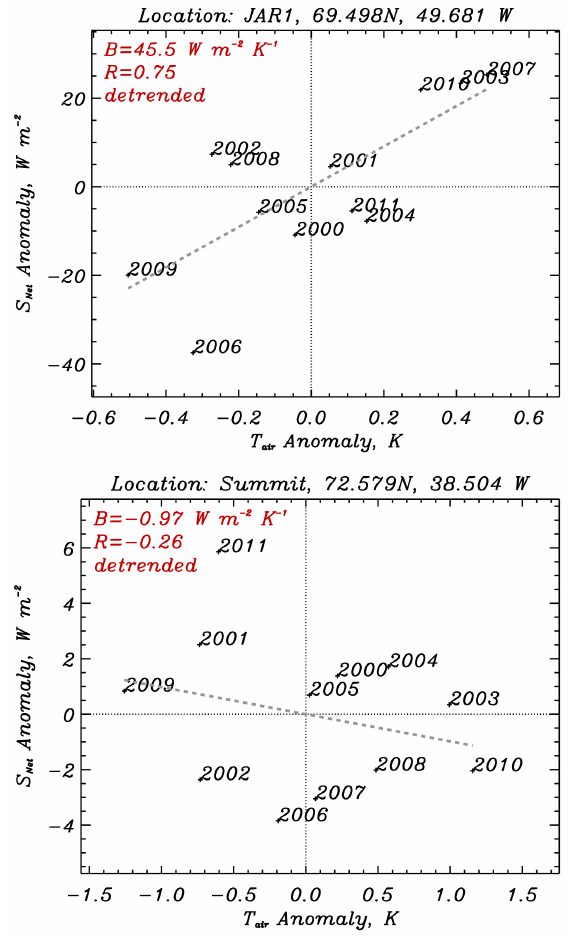
Fig. 5. Examples of albedo feedback calculated by regression of in- ter annual anomalies. The 5km grid cell locations illustrated here are coincident with GC-Net AWS sites, but more importantly illus- trate the differences between the ablation and accumulation areas. The dashed grey line indicates the regression slope that is here used to quantify the sign and magnitude of the albedo feedback.